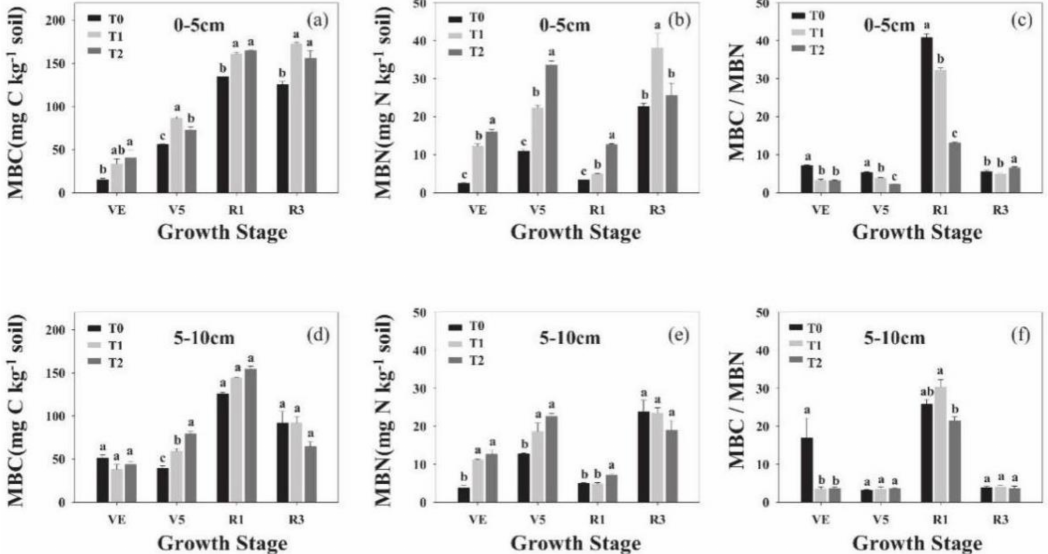
Figure 1. Soil microbial biomass carbon (MBC), soil microbial biomass nitrogen (MBN) and MBC/MBN ratio under three different residue placement treatments (T0, no residue; T1, surface; and T2, incorporated) in 0–5 cm soil layer ( a – c ) and 5–10 cm soil layer ( d – f ) at four growth stages during maize-growing season in the pot experiment. Mean value ± standard error ( n = 4) is shown. Different letters above the bars indicate statistically significant differences at p < 0.05.